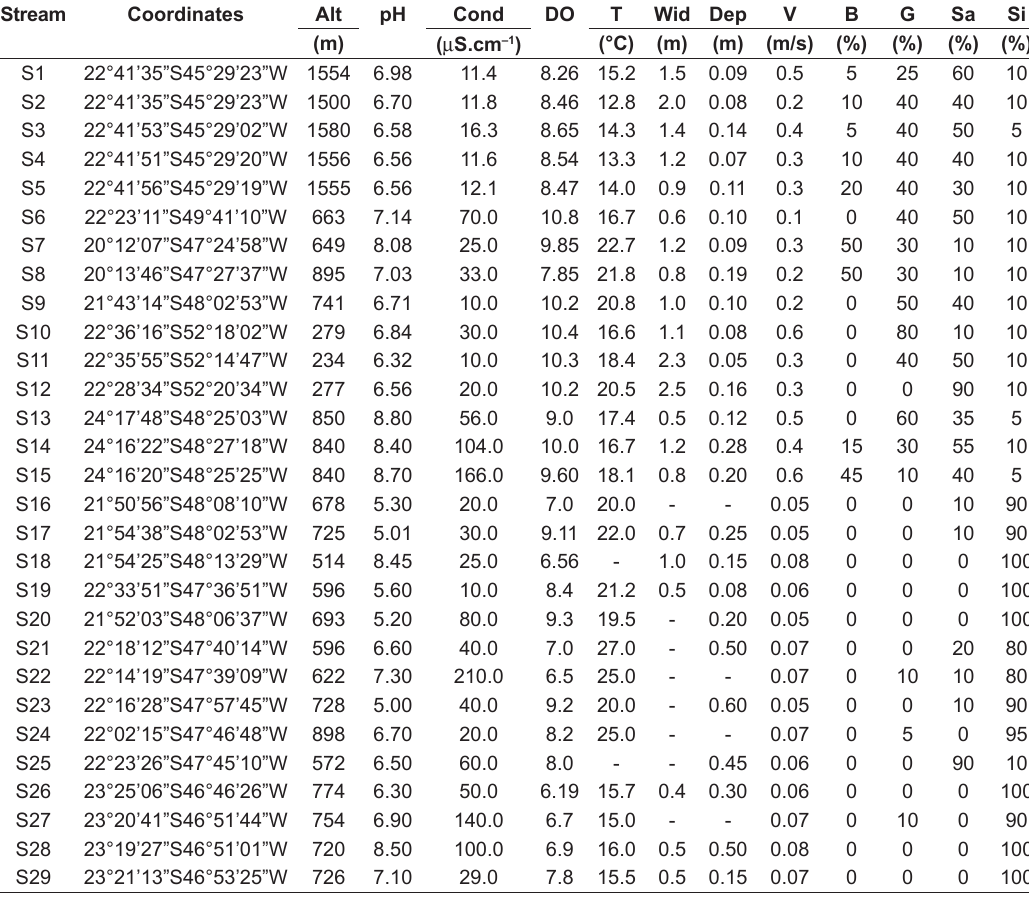
Table 1. Geographic data and environmental variables recorded in sampled streams in São Paulo State: map coordi- nates and altitude (Alt); pH, electrical conductivity (Cond), dissolved oxygen (DO), temperature (T); mean width (Wid); mean depth (Dep); mean velocity (V); percent boulder (B); percent gravel (G); percent sand (Sa); percent silt (Si); (-) not recorded.